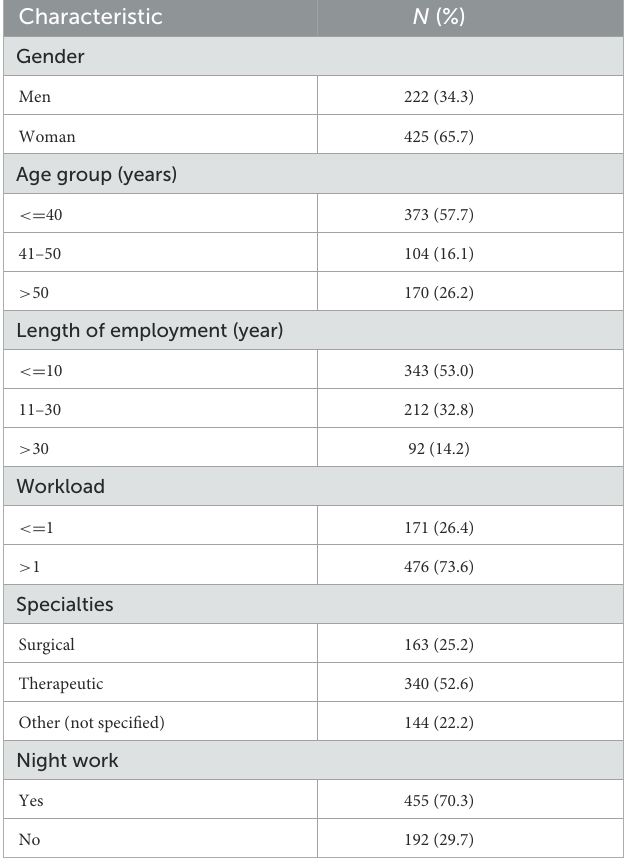
TABLE 1 The main sociodemographic and occupation-related characteristics of the study population.